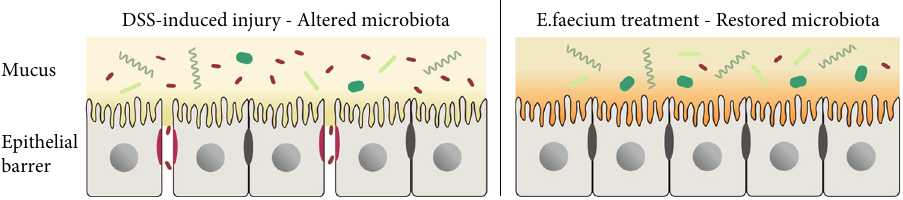
Figure 7: Working model of E. faecium treatment. E. faecium treatment improved the intestinal fl ora, thereby protecting the intestinal mucosa and reducing the damage to tight